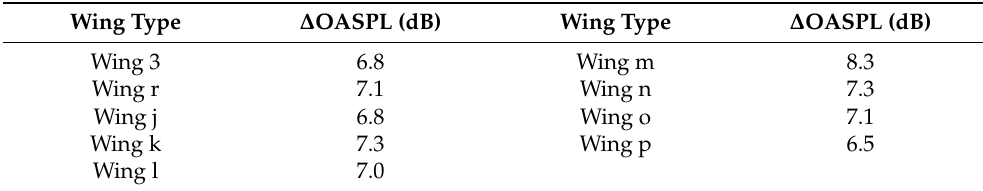
Table 7. Overall sound-pressure-level reduction of different bionic wings.